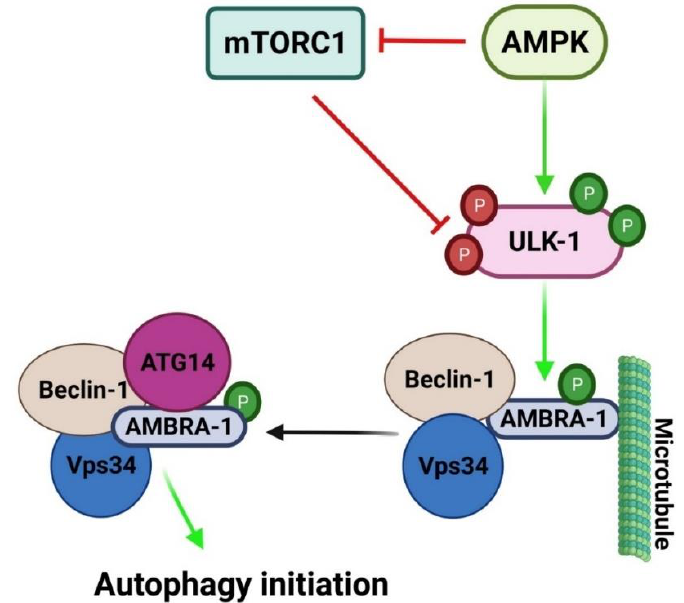
Figure 2. Regulatory mechanism for autophagic initiation. Under stressful micro environmental conditions, AMPK is activated, which in turn induces autophagy initiation either by inhibiting mTORC1 or direct phosphorylation of ULK-1 at Ser317 and Ser777. Activated ULK-1 phosphorylates AMBRA-1 that is attached to Beclin-1/Vps34 and results in its dissociation from the microtubule. This activates the assembly of ClassIII PI3K leading to autophagy initiation. mTORC-1 negatively regulates autophagy through inhibition of ULK-1 via phosphorylation at Ser757. Green arrow indicates activation, red arrow indicates inhibition and P indicates phosphorylation. Created with BioRender.com (accessed on 15 Oct 2021).